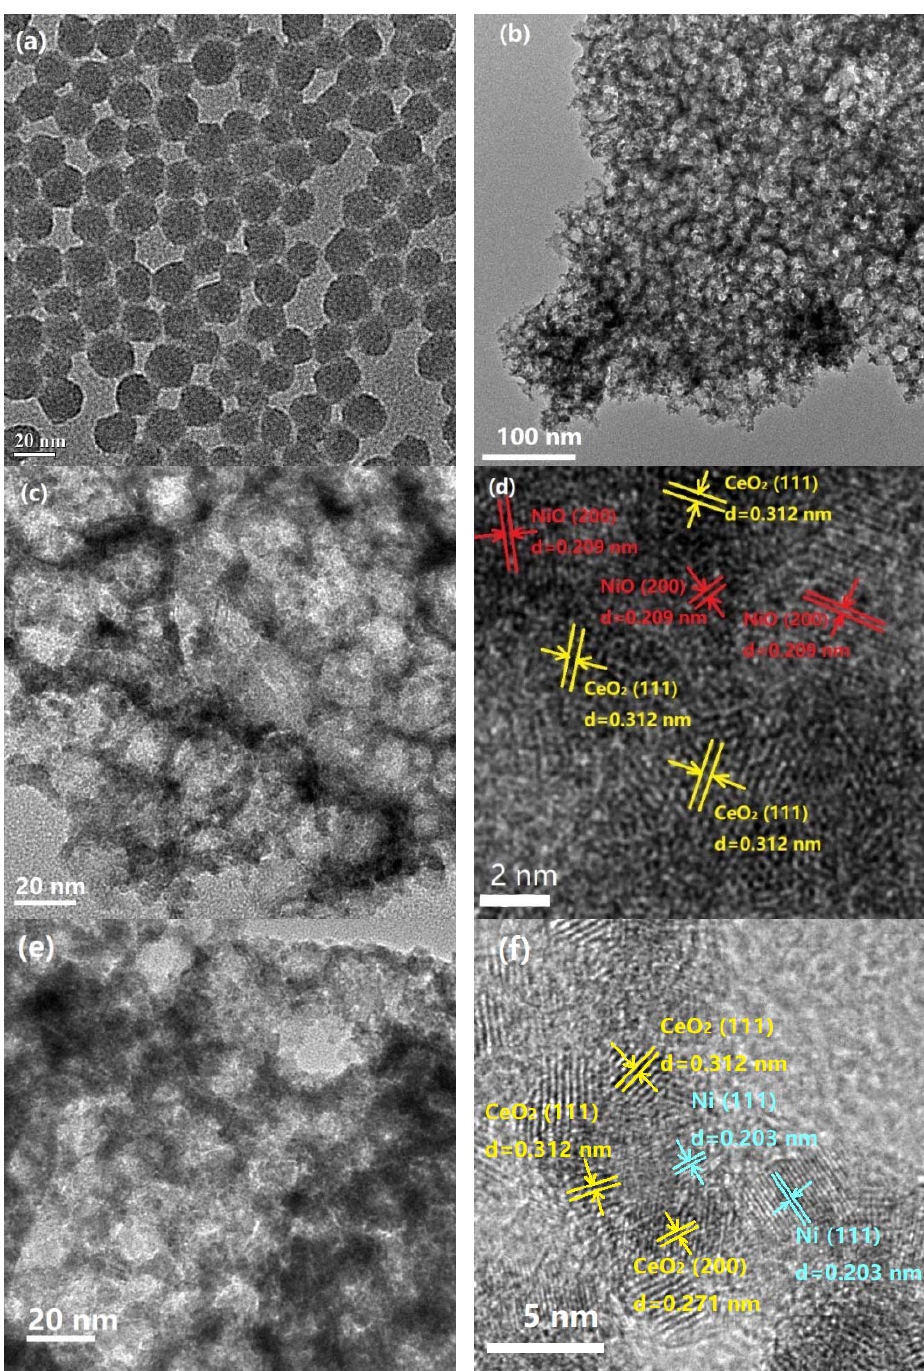
Figure 3. Transmission electron microscopy images of ( a ) the colloidal SiO 2 , ( b – d ) the fresh 50% Ni-CeO 2 -CSC and ( e,f ) the reduced 50% Ni-CeO 2